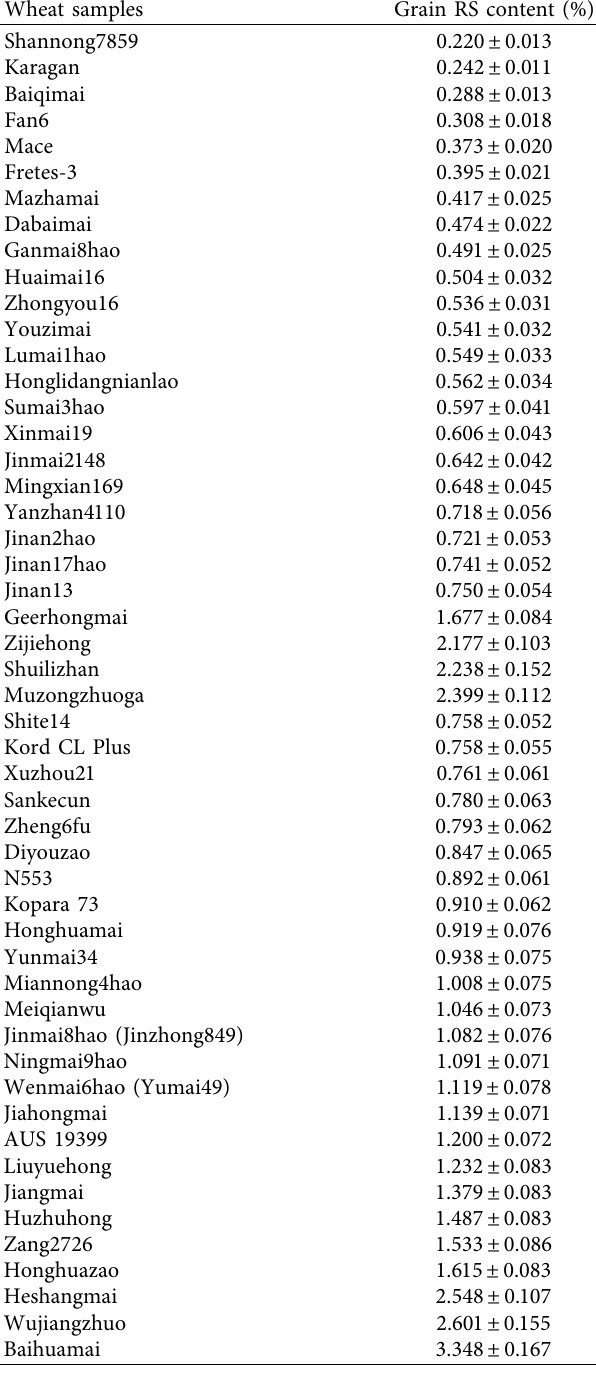
Table 1: Wheat samples in the calibration set and the grain RS content measured by the chemical